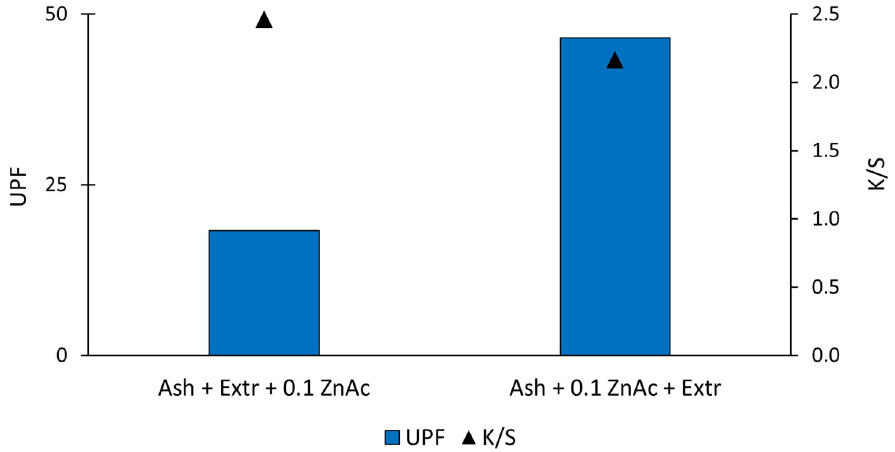
Figure 5. UPF and K/S values of the functionalised cotton samples.